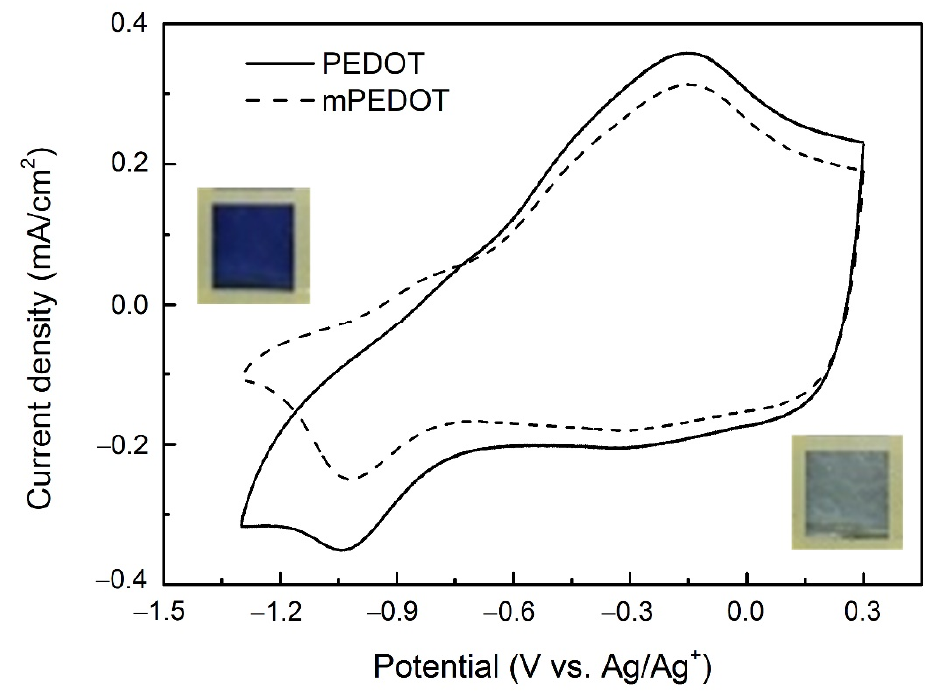
Figure 3. Cyclic voltammograms of the mPEDOT and PEDOT thin films prepared using Q d of 20 mC/cm 2 . The scan rate was 100 mV/s. The electrolyte was a PC solution containing 0.1 M LiClO 4 and 1.0 mM HClO 4 . The inset optical images are the colored state (left side) and the bleached state (right side) images of the mPEDOT thin film.